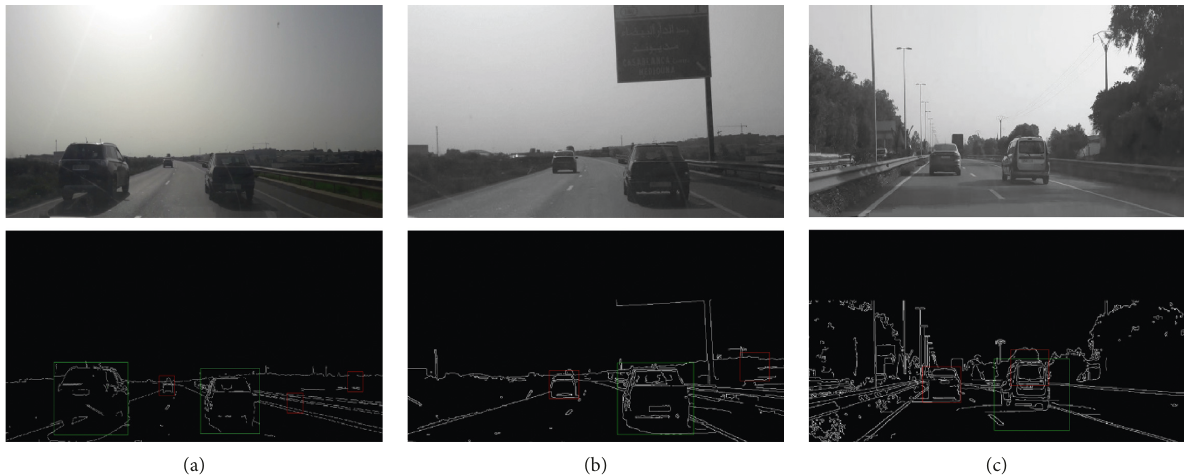
Figure 10: Hypothesis generation result after cross-correlation: (a) very close and very far generated candidates; (b) very close and far generated candidates; (c) close and far generated candidates.